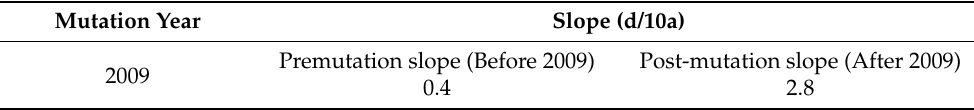
Table 1. Mann–Kendall test of annual number of extreme maximum temperature event